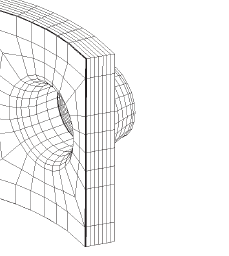
Figure 2: 3D Finite Element model of a main coolant pipeline nozzle 